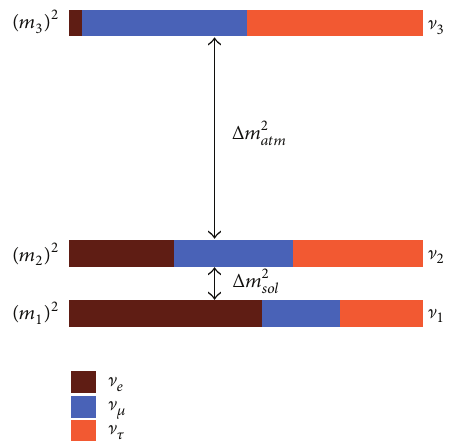
Figure 1: Illustration of the “ ] SM” showing mass states and mixings. Note that this drawing depicts only one possible mass ordering. There remain many open questions that surround this data-driven picture of neutrinos and